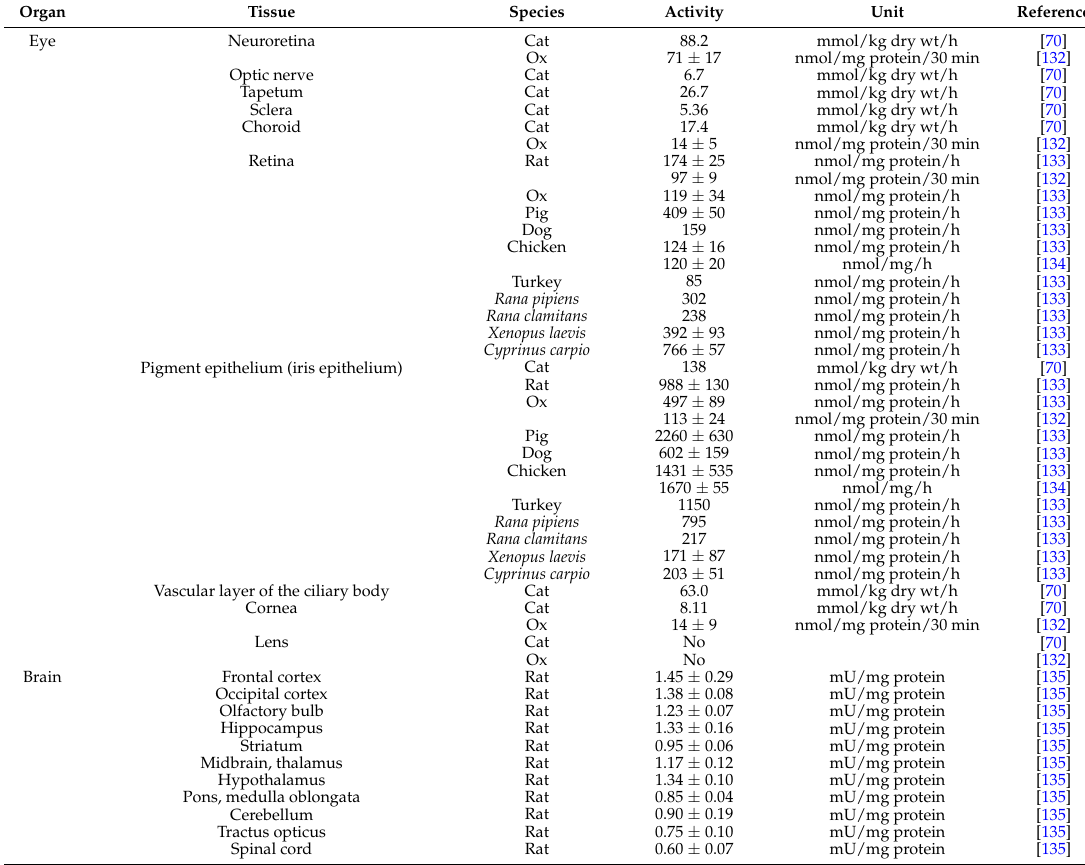
Table 3. OAT activity measured in various tissues, with no enzyme isolation.